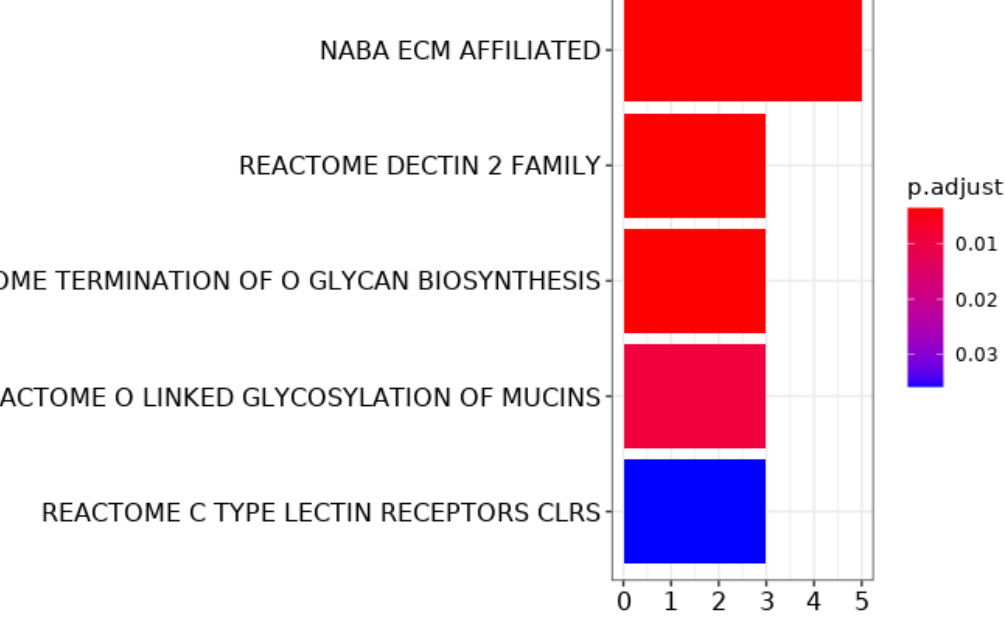
Figure 4. Bar plot of enrichment analysis. Pathways are on the y -axis, the number of genes in the pathway overlapping with the 26 most commonly mutated genes on the x -axis. The colour shows the p -value after the hypergeometric test, adjusted for multiple testing.